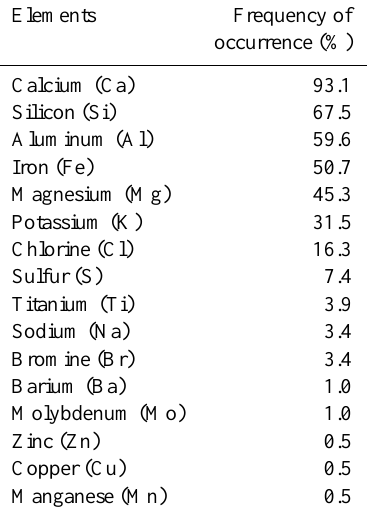
Table 4. Frequency of occurrence (%) of elemental composition of 203 individual particles from two samples collected on 27 May and 15 November 2010, as measured by individual particle analysis using an ESEM and EDS.